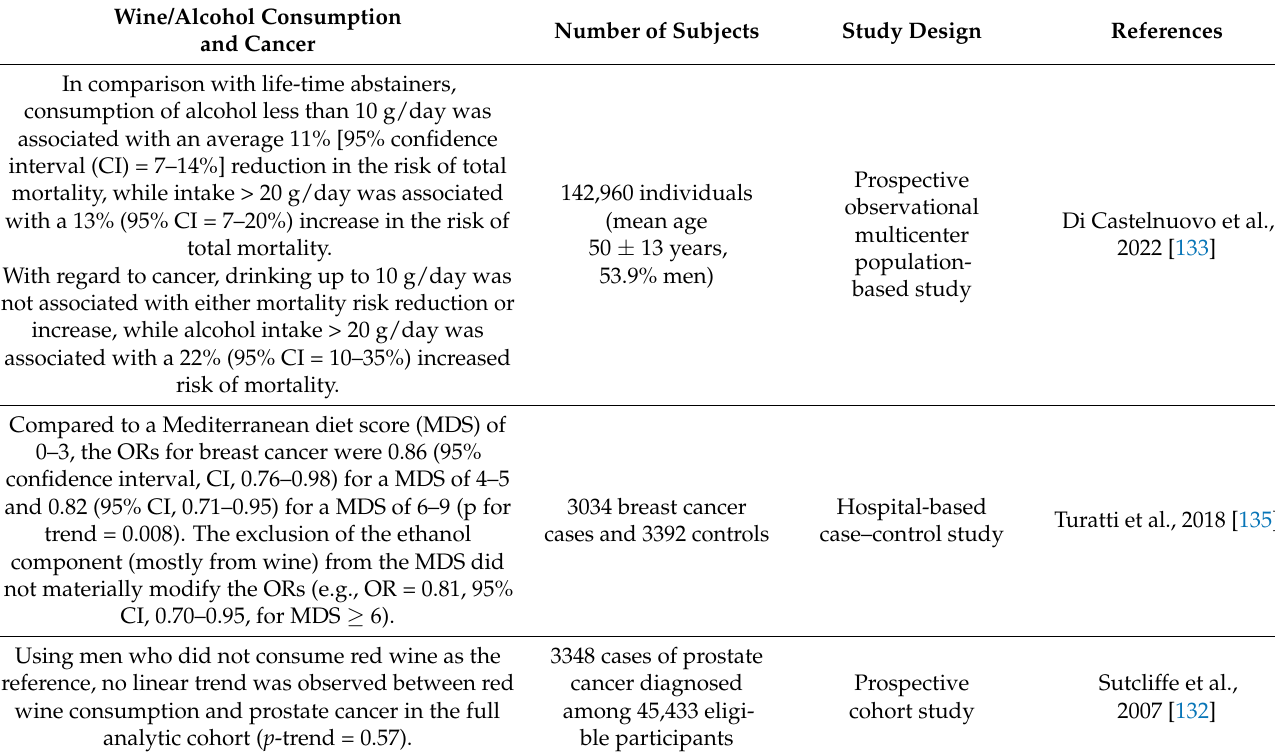
Table 4. Studies that considered wine and cancer